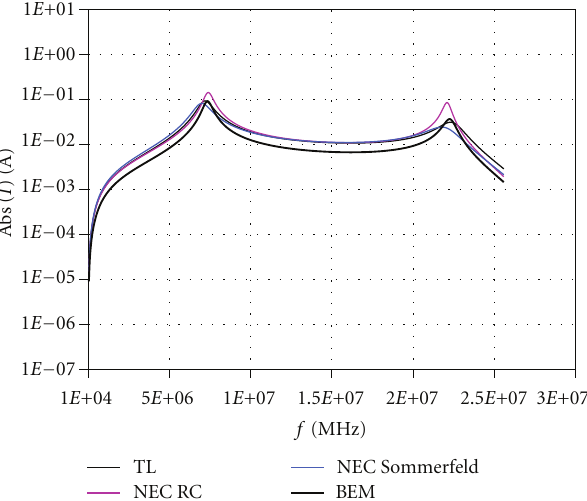
Figure 6: Current induced at the center of the line above a lossy ground versus frequency ( σ = 0 . 001S/m, ε r = 10).